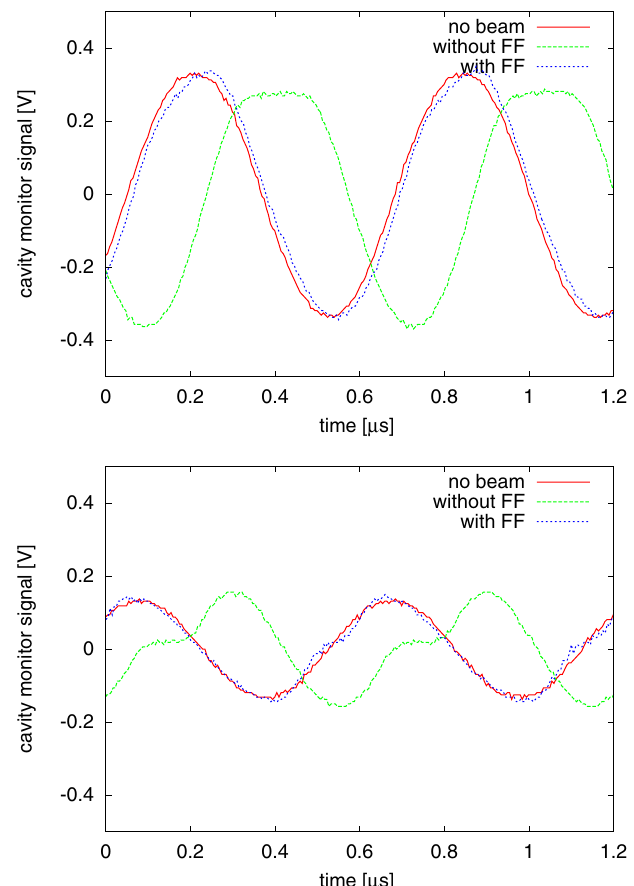
FIG. 16. Comparisons of cavity #1 voltage monitor waveforms in the cases of no beam, without feedforward, with feedforward. The beam intensity is 300 kW equivalent—(top) middle of acceleration period and (bottom) just before